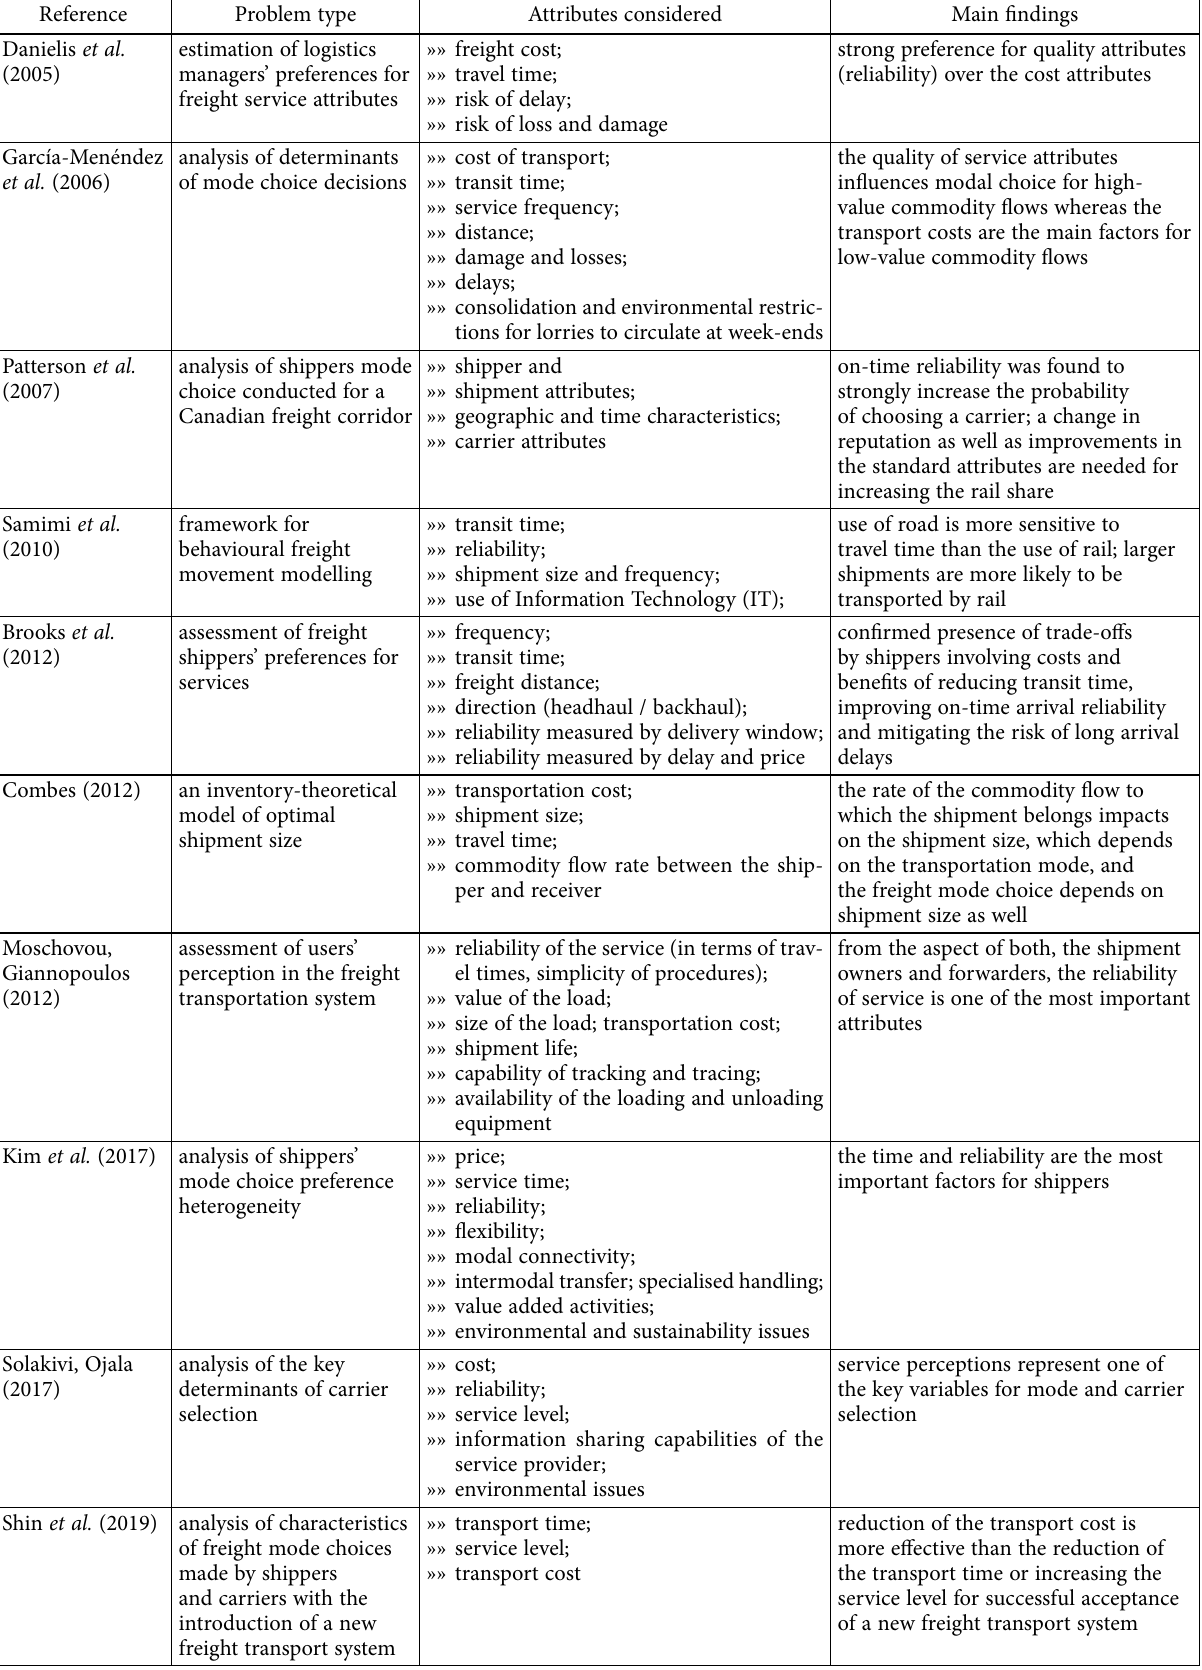
Table 1. Summary of the most relevant contributions dealing with analysis of transport performance